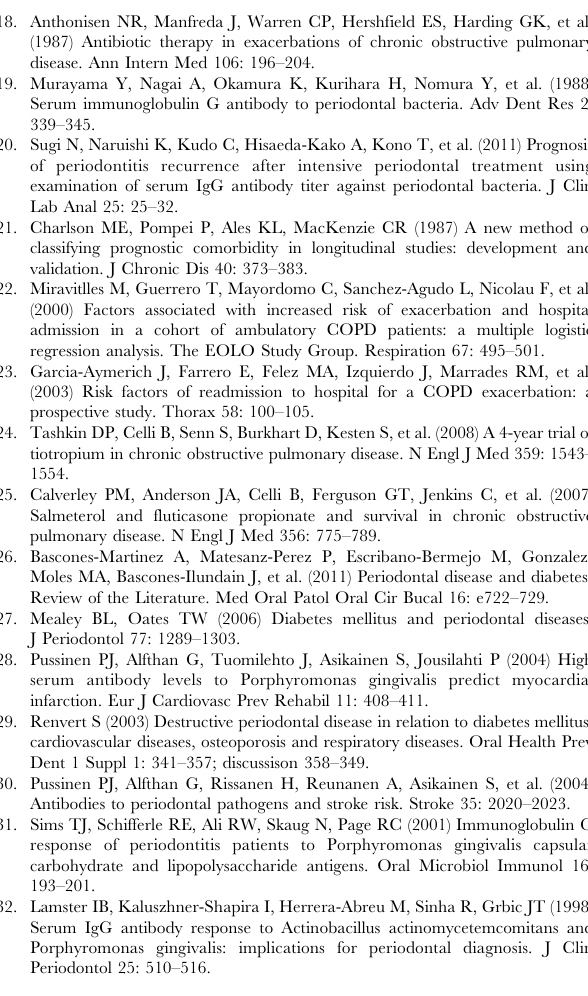
Figure S1 Frequency of exacerbations of patients with COPD and serum IgG antibody titer against Porphyr- omonas gingivalis . Annual frequency of exacerbation is not correlated with Porphyromonas gingivalis -related antibody titers (p = 0.1128). Table S1 Patients’ baseline characteristics (n =62). Table S2 Comparison of 27 cytokines between patients with normal and higher IgG titer against Porphyromonas gingivalis : subanalysis of 62 patients.